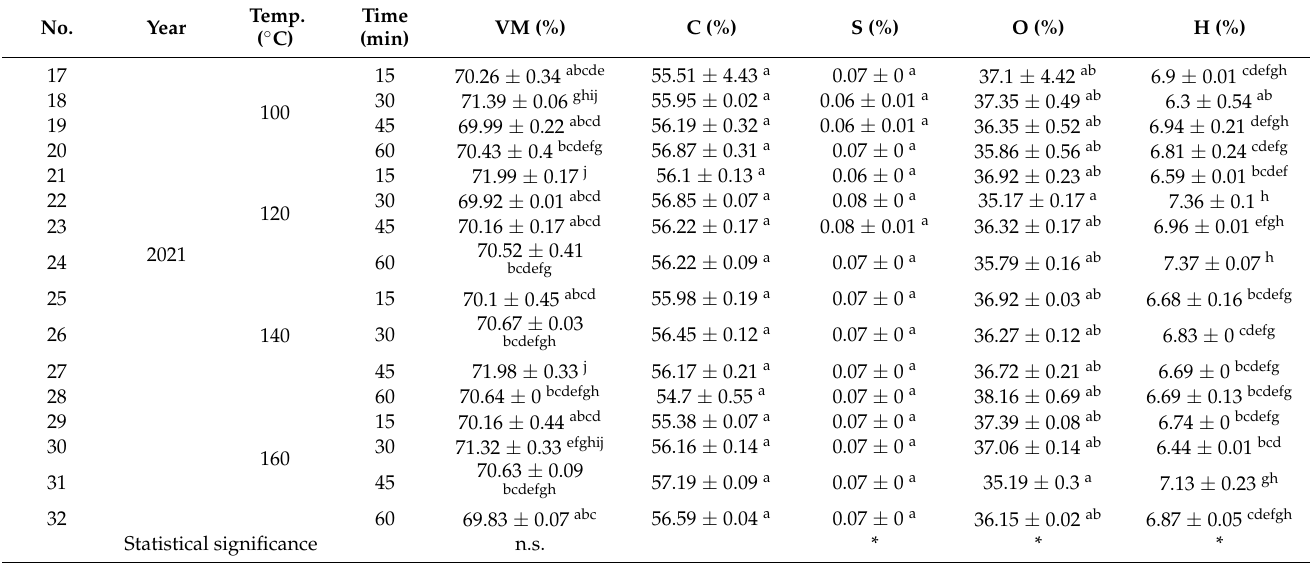
Table 4. Content of combustible substances in hazelnut shell after conductive drying